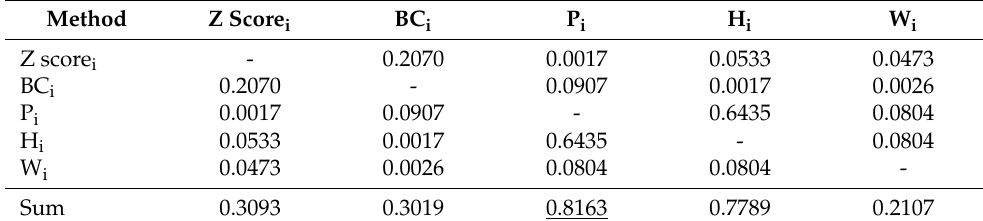
Table 7. Matrix of determination coefficients (R 2